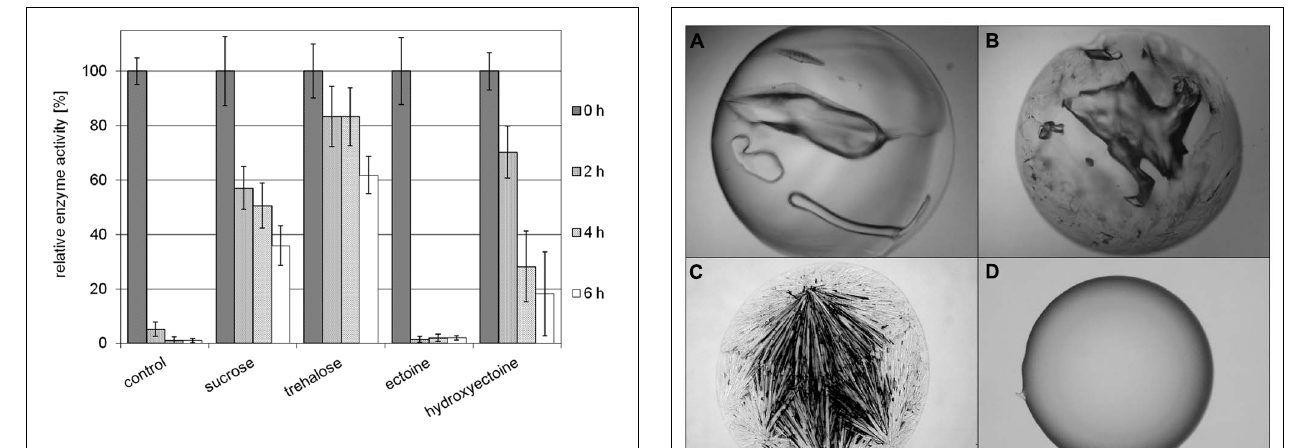
FIGURE 5 | Relative enzyme activities of LDH after prolonged air drying at 60 ◦ C for 2, 4, and 6 h. Activities of unstabilized enzyme (control) and of enzyme protected by sucrose, trehalose, ectoine, and hydroxyectoine, respectively, are shown (error bars show standard deviations of at least four to a maximum of six replicates).